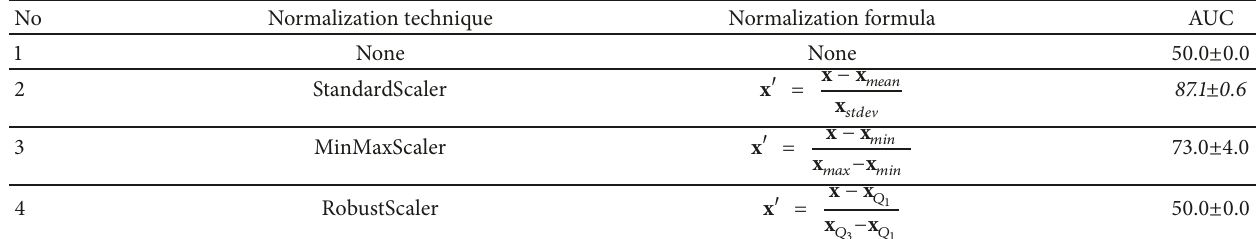
Table 2: Performance results of HAOC using several normalization techniques for KRBDS.